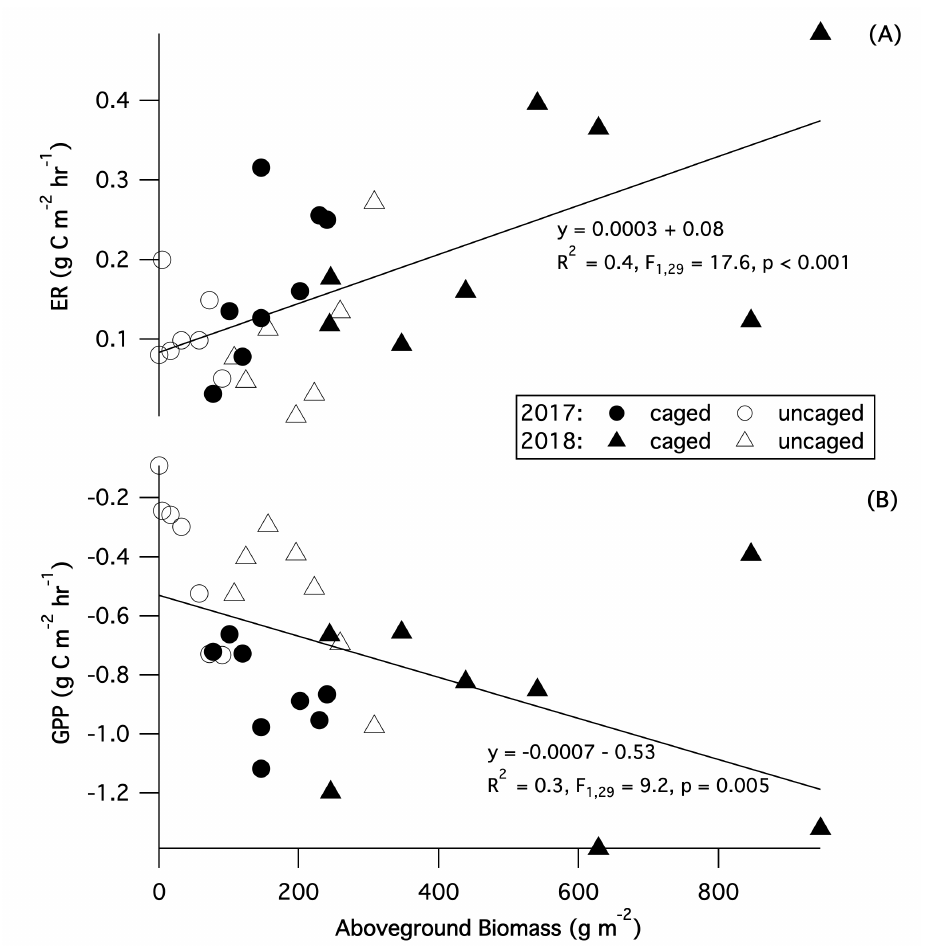
Figure 5. Relationship between peak growing season (July) aboveground biomass and ( A ) ecosystem respiration (ER) and ( B ) gross primary production (GPP). Regression analysis includes data from all plots and years in which both biomass and gas fluxes were measured (n =